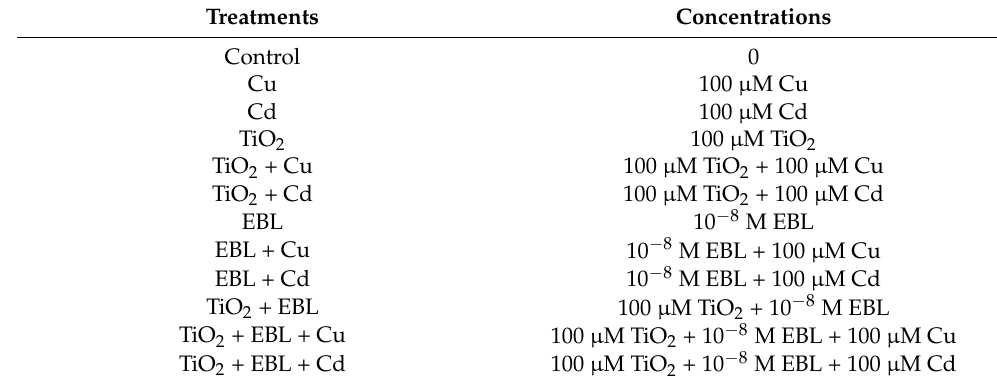
Table 1. The treatment combinations of the experiment. Treatments Concentrations